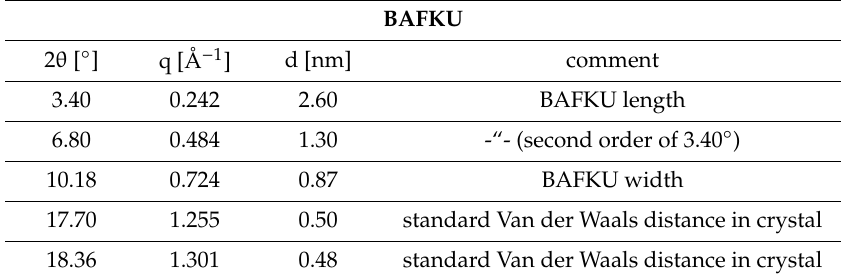
Table 2. X-ray diffraction results. BAFKU: interference maxima and the corresponding characteristic distances.